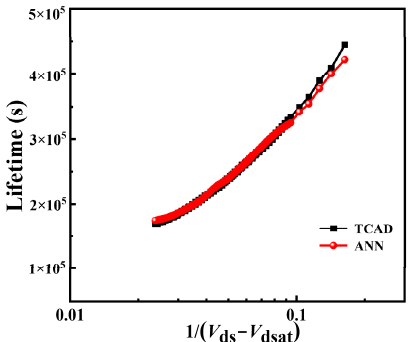
Figure 11. ( a ) The extrapolation MSE of the ANN algorithm. ( b ) Comparison of I ds degradation between ANN algorithm and TCAD simulation at V ds = 13 V.